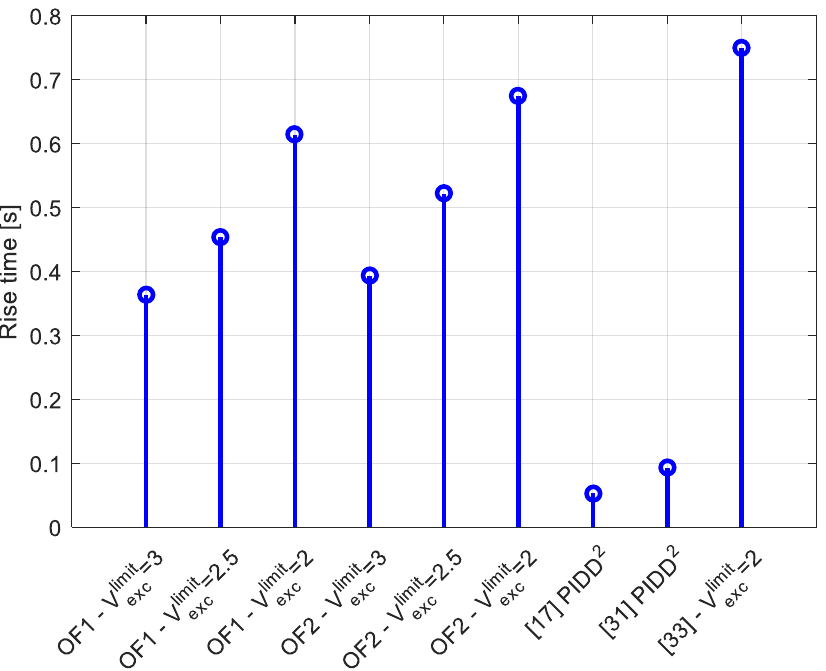
Figure 11. Comparison of the results in terms of the rise time obtained using different methods.